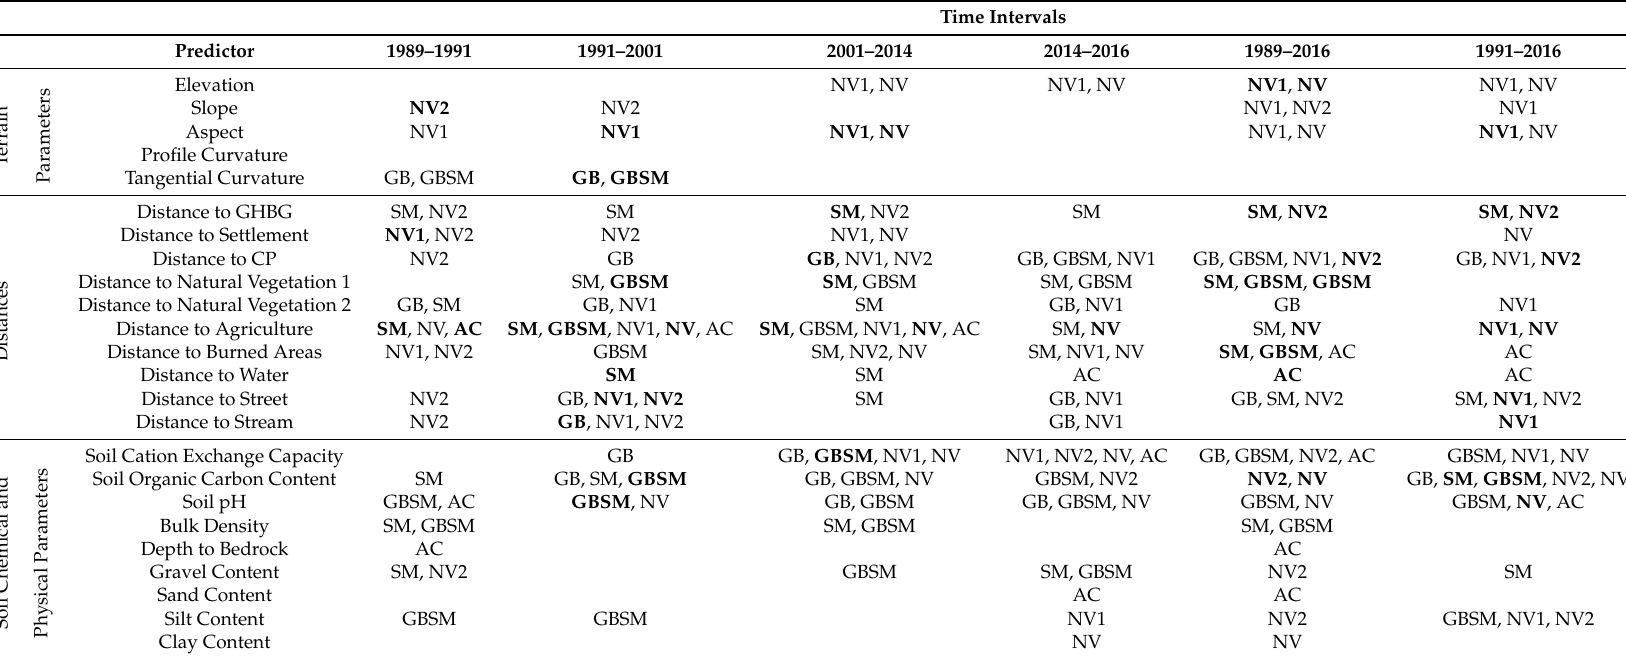
Table 3. Synopsis from the Multiple Regression Analysis tables. The second column indicates the used predictors in the Multiple Regression Analysis for the tested time intervals. If a statistical relation between change of the land cover and a tested parameter exists, it appears significant in the regression tables for the distinct time interval. This table summarizes the classes Greenhouses and Bare Ground (GB), Settlement (SM), the combined classes Greenhouses and Bare Ground and Settlement (GBSM), Coniferous Plantations (CP), Natural Vegetation 1 (NV1), Natural Vegetation 2 (NV2), the combined classes Natural Vegetation 1 and Natural Vegetation 2 (NV) and, Agriculture class (AC). Highly significant results ( p < 0.001) appear in